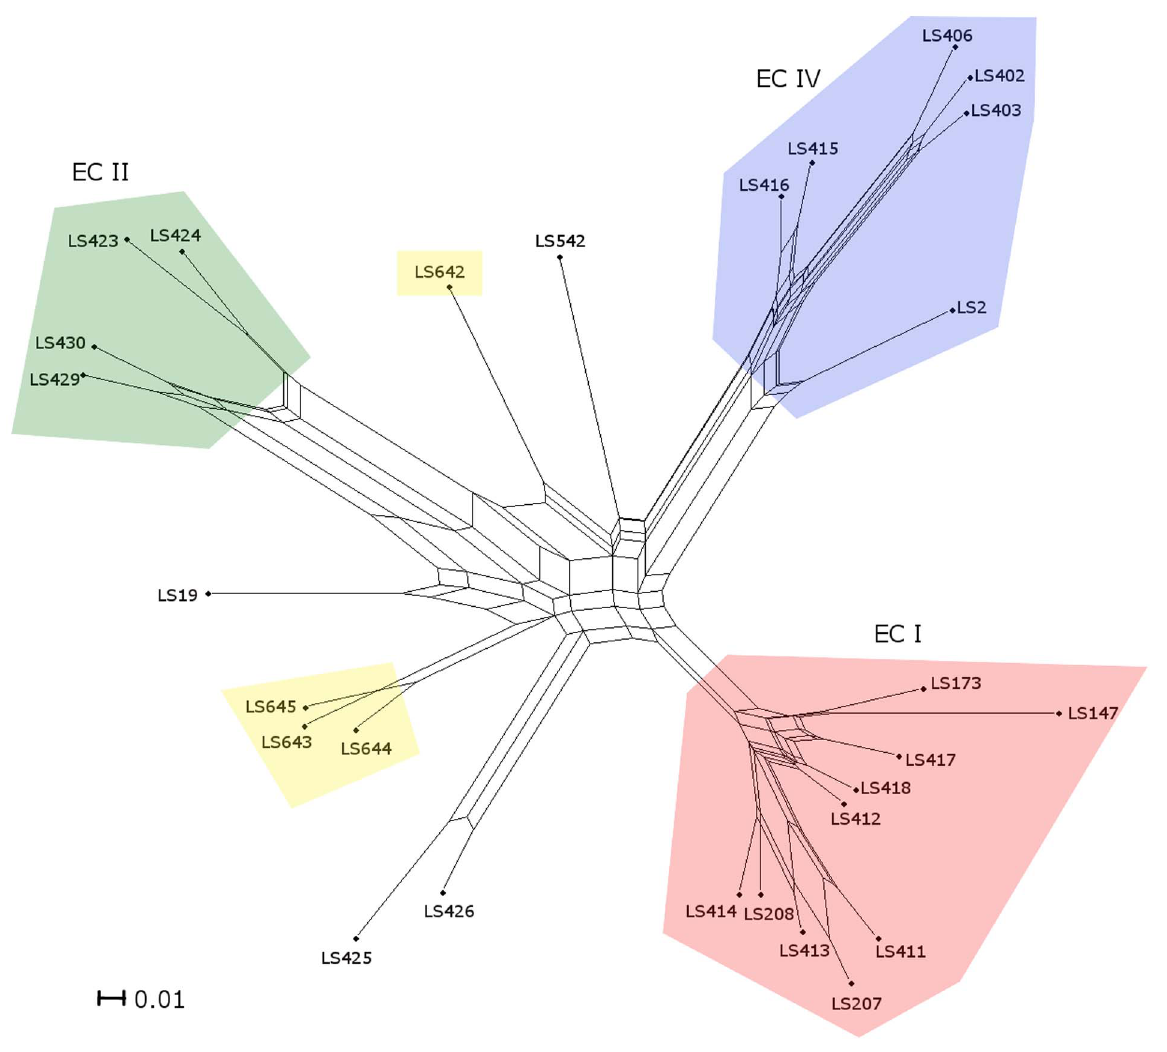
Figure 3. A neighbor-net constructed from the gene contents of 28 strains belonging to serotype 4b. The parallel edges represent incompatible signals indicative of independent gene loss or gain due to the multiple transduction or recombination. Serotypes and epidemic clones are grouped in different color as indicated. Node labels refer to strain names (Table 1 and Laksanalamai et al 2012 (7). Scale bar represents number of gene differences (present or absent) per gene site.